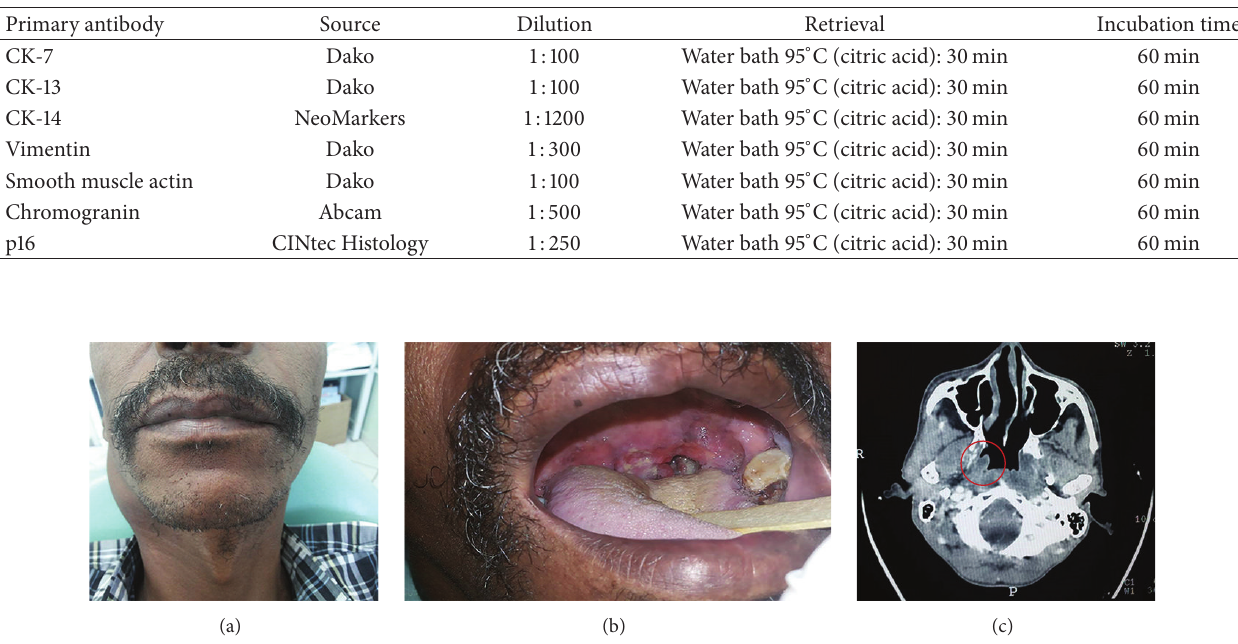
Table 1: Specifications of the primary antibodies.